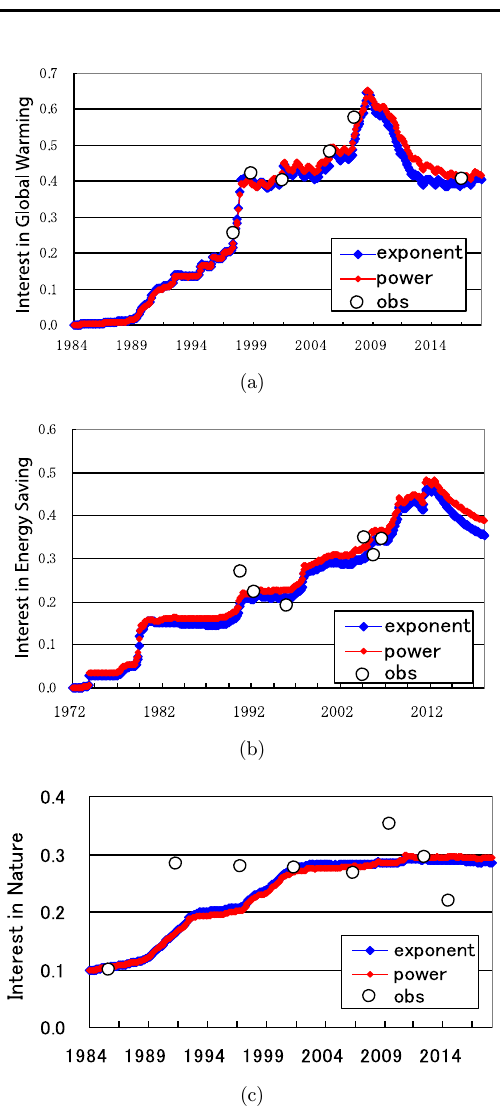
Fig. 6. Comparisonofcalculationwiththe observedpublicinterest in(a)the global warming, (b)the energy saving and (c) nature. The averaged interest between male and female is used for the observation in